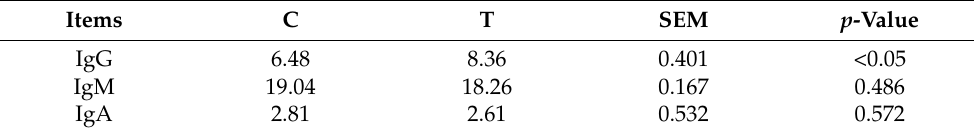
Table 6. Effects of supplemental resveratrol on the immunoglobulin levels (ng/mL) in Hanwoo calves. Items C T SEM p